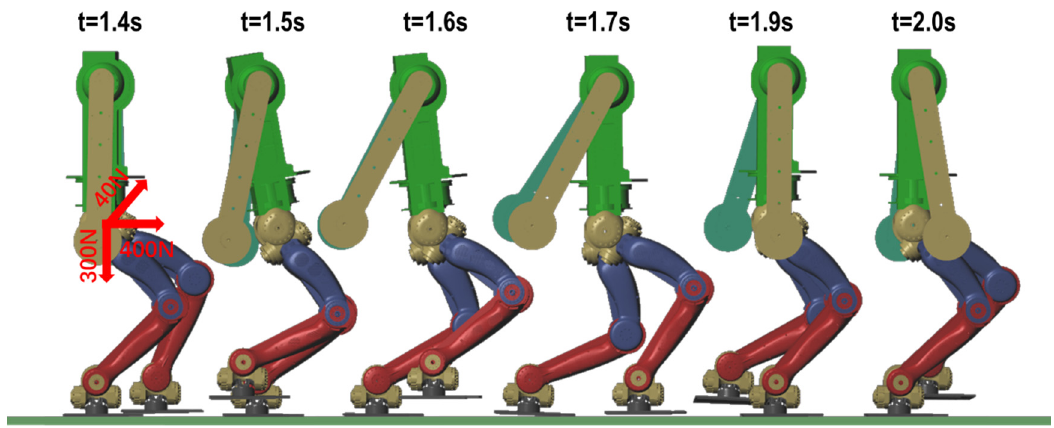
Figure 7. Disturbance recovery in walking.